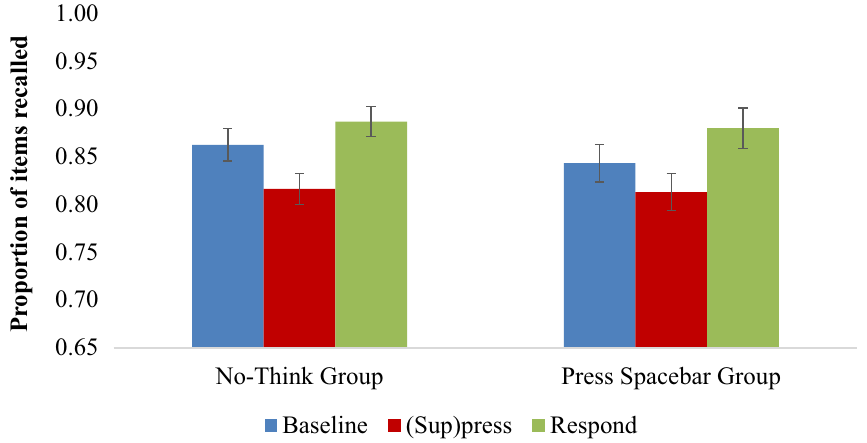
Figure 1. Mean recall proportion for Baseline (blue), (Sup)press (red), and Respond (green) aggregated by Test Type for Experiment 1. Error bars represent standard errors of the